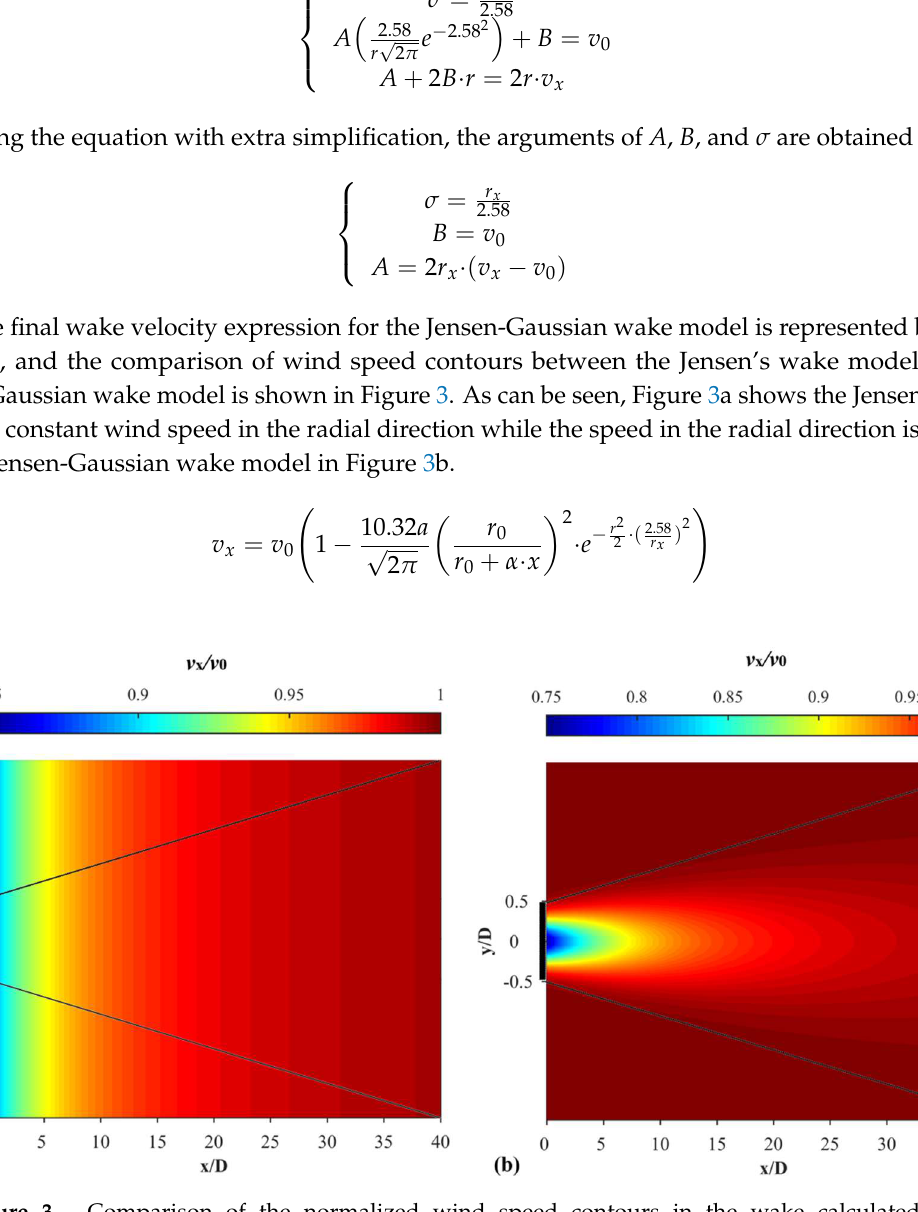
Figure 3. Comparison of the normalized wind speed contours in the wake calculated by: ( a ) one-dimensional Jensen wake model and ( b ) two-dimensional Jensen-Gaussian wake model.